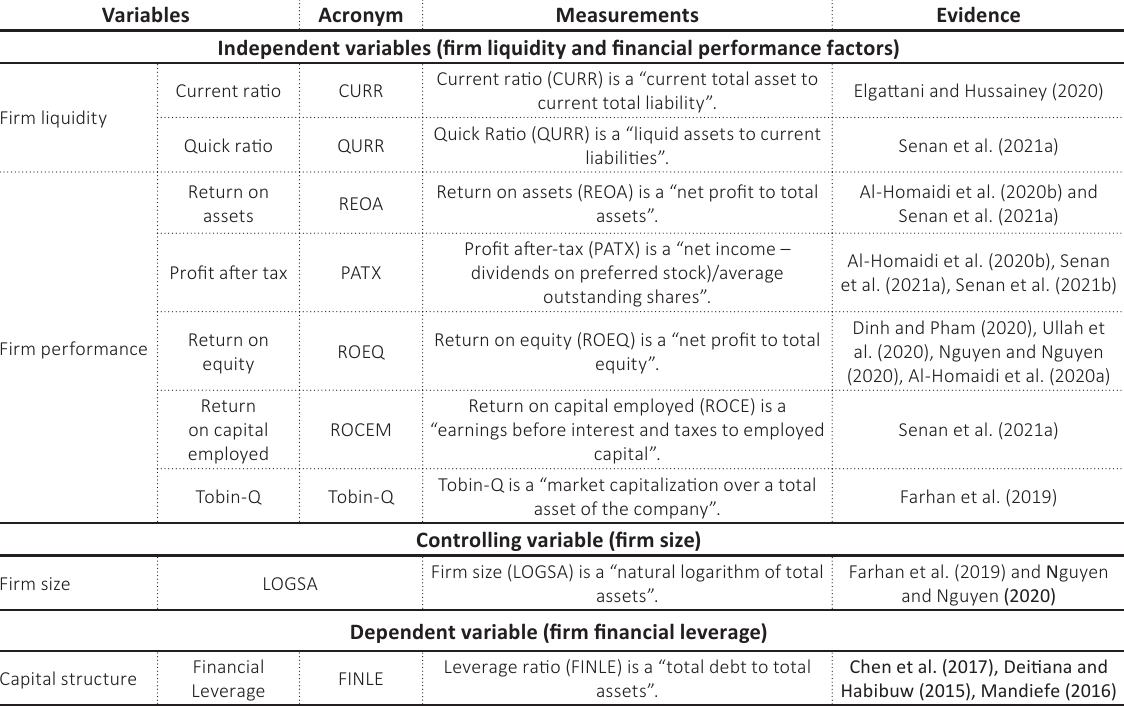
Table 2. Measuring variables of the current review